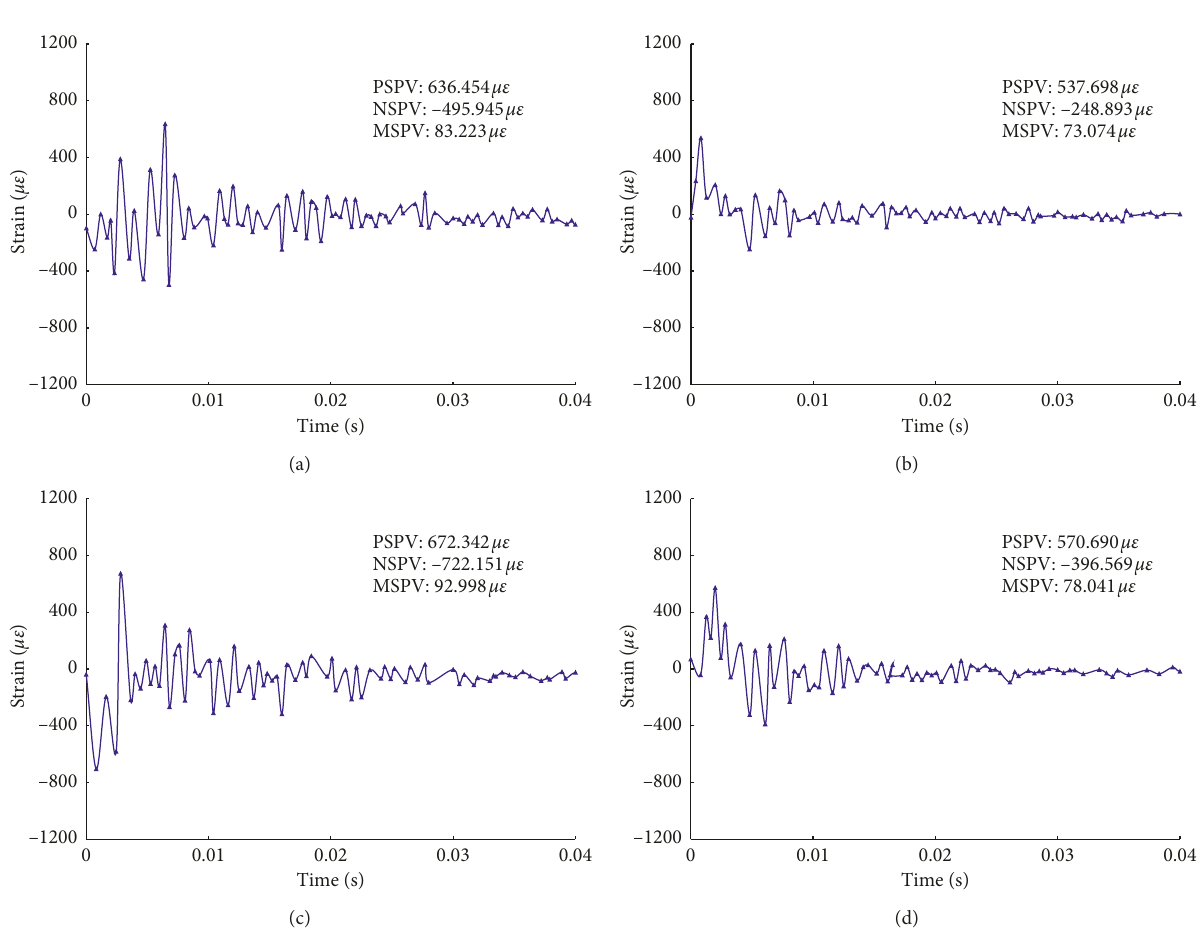
Figure 5: Waveform curve of dynamic strain for #1 test model: (a) #E1-1 test point, (b) #E1-2 test point, (c) #E1-3 test point, and (d) #E1-4 test